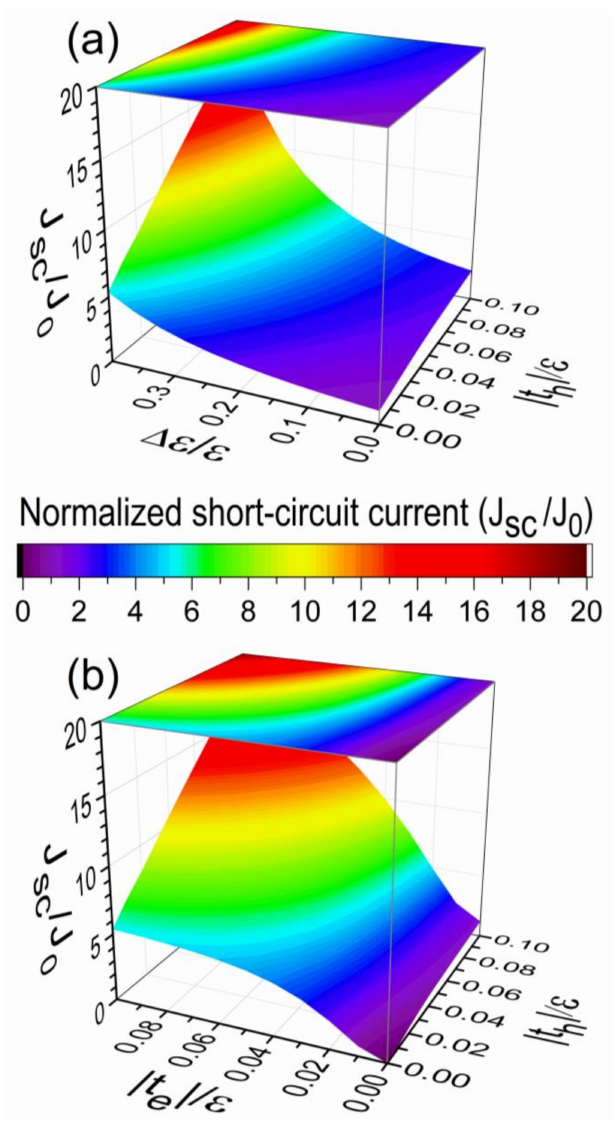
Figure 3. (Color online) Normalized short-circuit current ( J SC / J 0 ) ( a ) as a function of the hopping integral t h and ∆ ε with t e = − 0.1 ε and ( b ) versus hopping integrals t e and t h with ∆ ε = 0.4 ε for an excitonic lattice of ( N h + 1 ) × ( N e + 1 ) = 67,108,864 × 200 states. The electron-hole recombination rate used was Γ = 0.01 ε and an imaginary part of energy of η = 10 − 3 ε